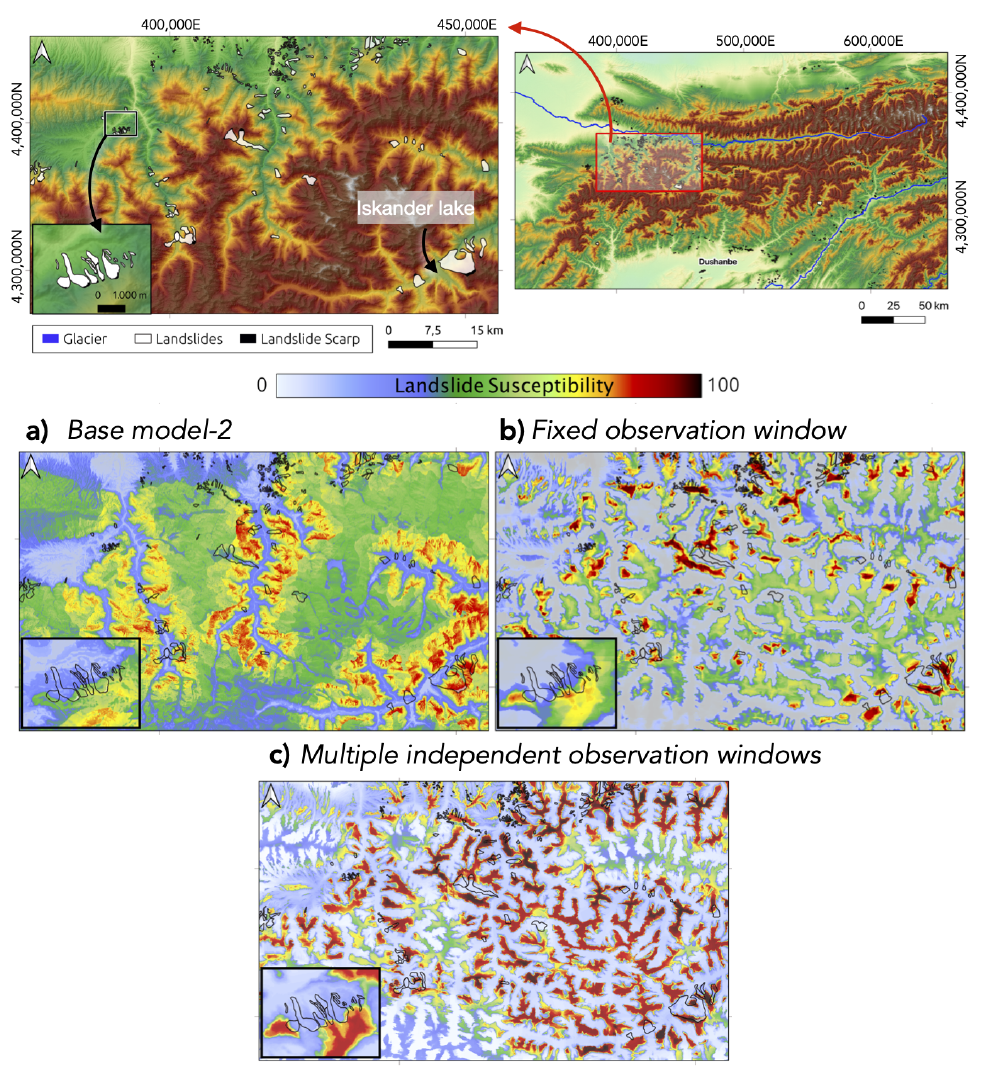
Figure 8. Mean landslide susceptibility map in an area located at the western piedmont of the southwestern Tian Shan, south the Zeravshan river. This area contains landslides with variable size. Solid line and white filling: Landslide polygon. Black filling: Landslide scarp. The landslide susceptibility models are trained and evaluated on the landslide scarp. ( a ) Base model-2 that includes slope, aspect, geology, distance to fault, NDVI, precipitation, isothermality, TWI, distance from channel, and elevation above channel as source of information. ( b ) Model that includes the window-based morphometric indices calculated with an observation window fixed at 5000m. ( c ) Model that includes the window-based morphometric indices calculated with multiple and independent observation